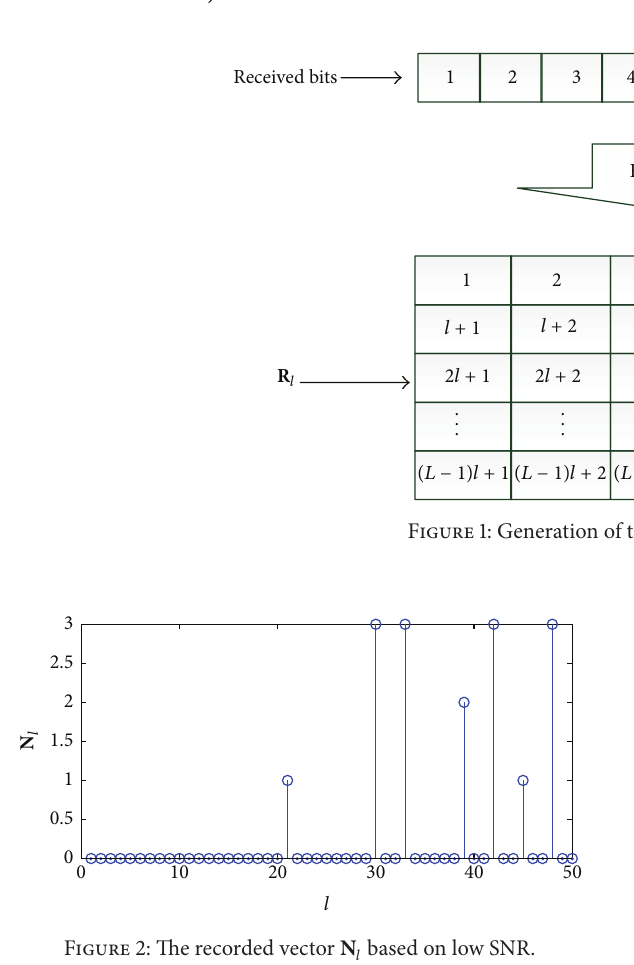
Figure 2: The recorded vector N 𝑙 based on low